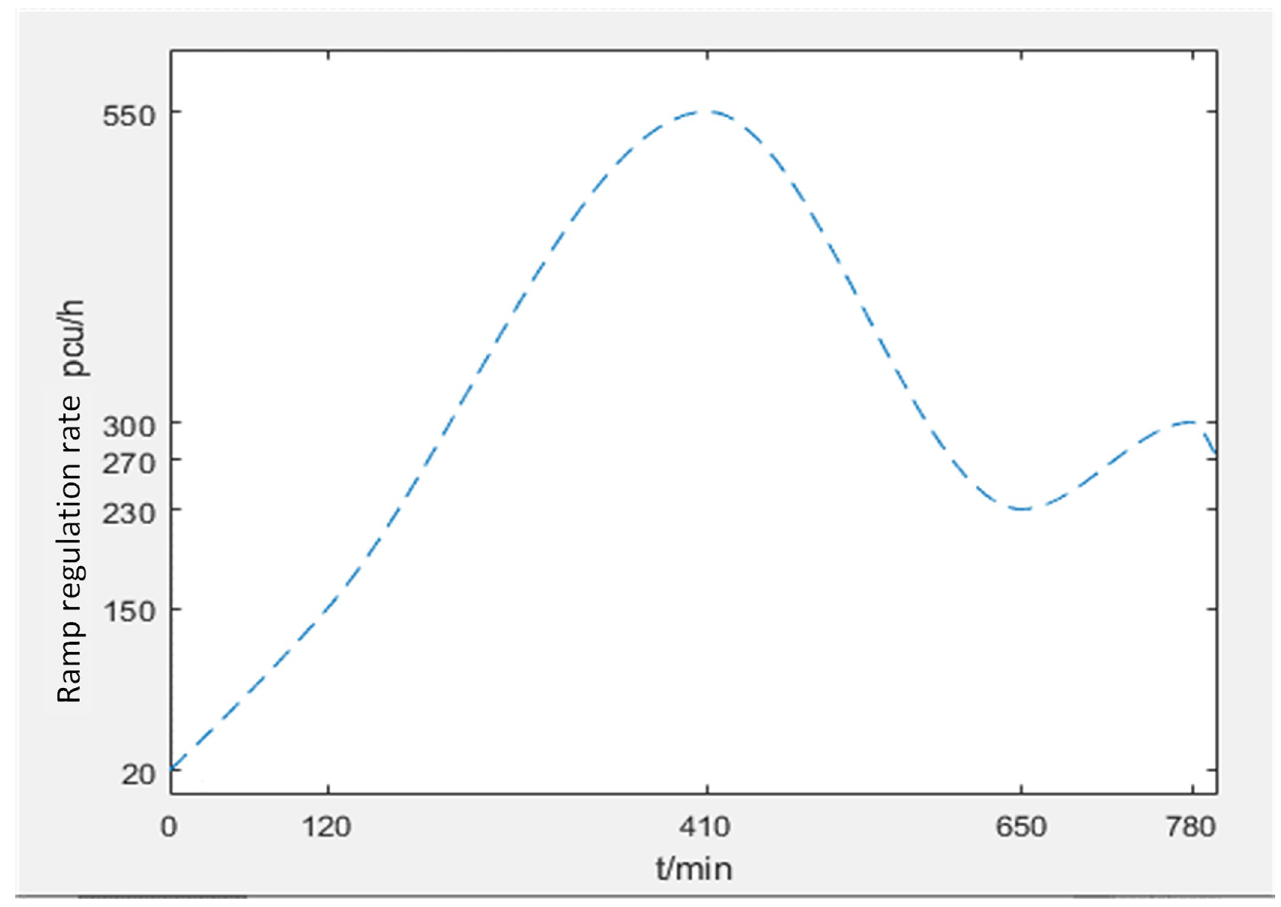
Fig 7. The curve of ramp